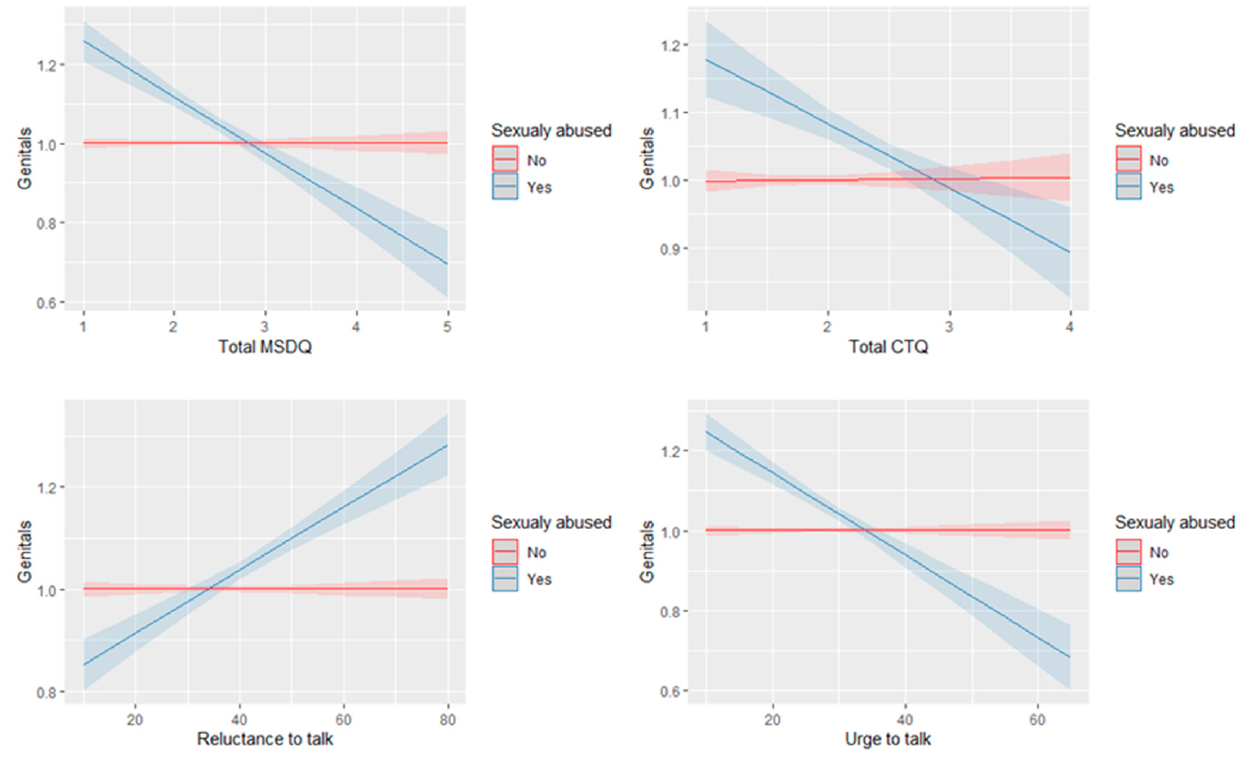
Figure 1. Visualization of significant interaction effect between experiencing CSA and MSDQ total score, CTQ total score, reluctance to talk score and urge to talk score, and the genital indicator. Experiencing CSA moderated the relationship between the urge to talk score and the hair indicator, ( ∆ R 2 = 0.005, F(1, 1703) = 7.6, p = 0.006). As illustrated in Figure 2, for CSA participants, a higher urge to talk score is associated with more obviousness of hair and ear indicators. For non-CSA participants, there is no relation between the urge to talk score and the obviousness of